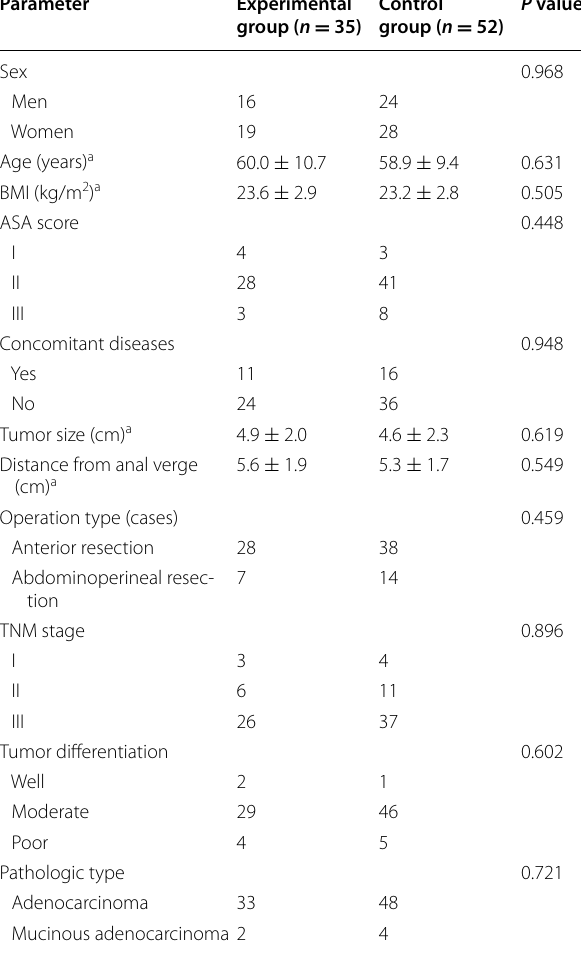
Table 1 Comparison of clinicopathologic characteristics in two groups of patients with mid-low rectal cancer